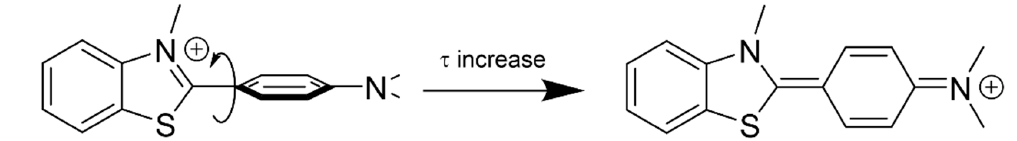
Figure 10. Schematic representation of the two limit conformations adopted by ThT [52].